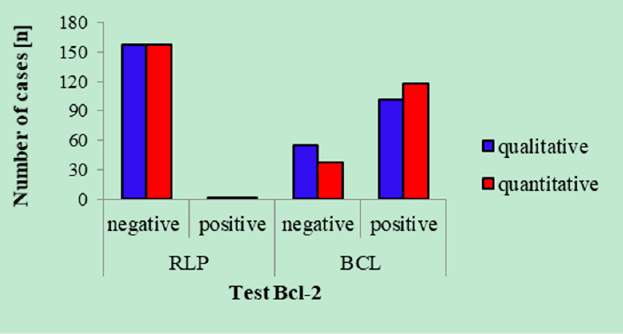
Figure 2. Results of the qualitative and quantitative Bcl-2 tests (Bcl-2 index of 1.5). RLP—reactive lymphocytic proliferation. BCL—B-cell lymphoma.